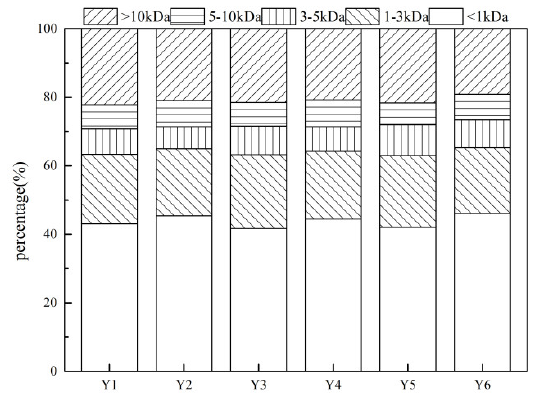
Figure 4. Molecular weight fractionations of KS-DON.